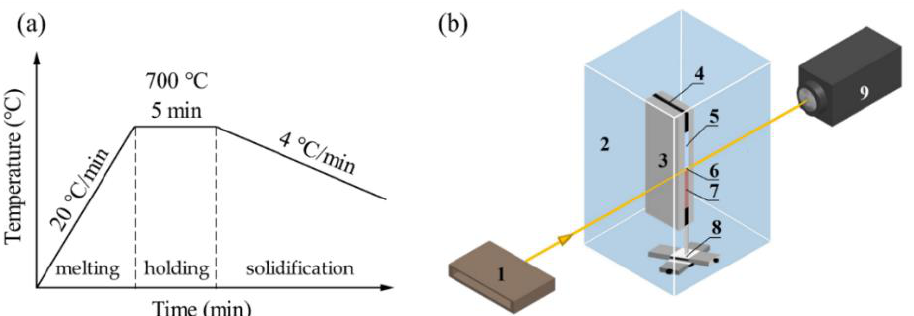
Figure 1. ( a ) The schematic of the heating and cooling profile; ( b ) the schematic diagram of synchrotron radiation experimental setting. 1 Synchrotron radiation X-ray, 2 vacuum furnace, 3 ceramic plate, 4 mica sheet, 5 pure Al, 6 interface, 7 pure Cu, 8 sample holder, 9 CCD camera. The experiments were carried out on beamline BL13W1 of the Shanghai Synchrotron Radiation Facility (SSRF) in Shanghai, China, using a monochromatic 22 keV X-ray beam. A YAG: Ce scintillator screen was used to convert the transmitted X-rays to visible light. The time-sequenced images of the microstructural evolution and IMC formation at the liquid Al/solid Cu interface were recorded by a fast-read-out, low-noise charged couple device (CCD, Hamamatsu, Japan) camera with a resolution of 0.65 µ m per pixel at a frequency of 1 frame per second. The radiography image quality is improved by image processing [18], which consists of subtracting the original image of the sample taken at a time t by a reference image recorded just before the experiments. The schematic diagram of the synchrotron radiation experimental setting is shown in Figure